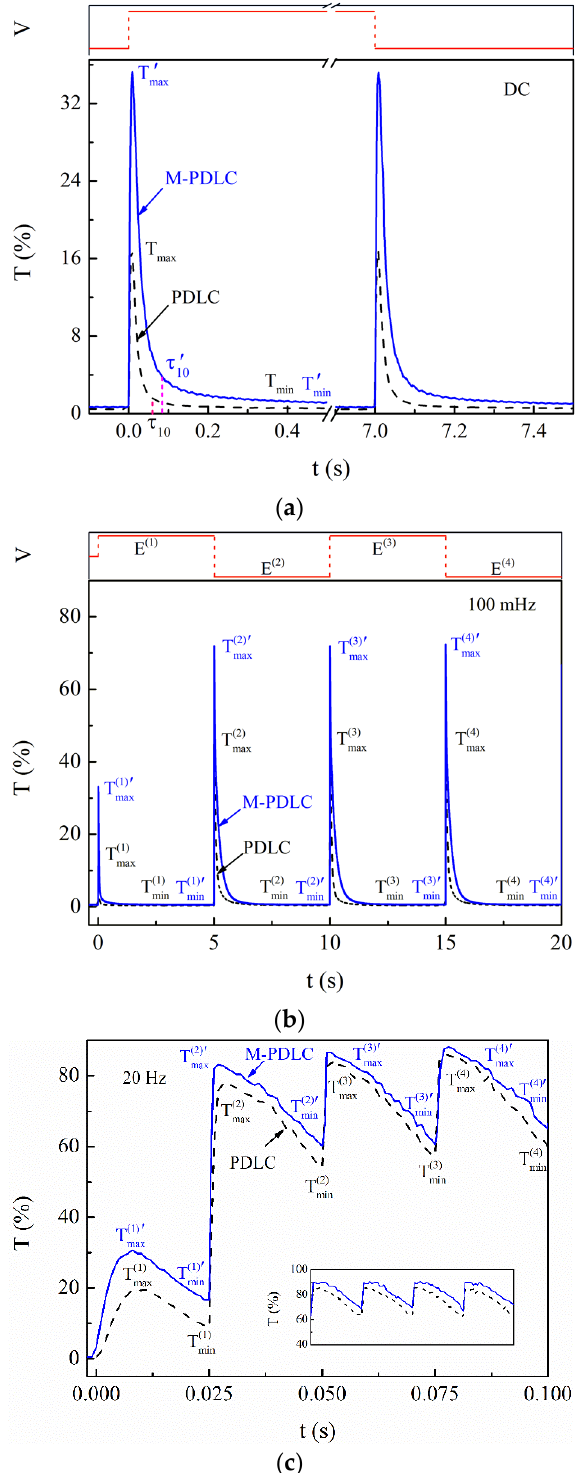
Figure 7. The T-t curves of the PDLC film and M-PDLC film applied with a DC voltage and an AC square wave voltage at 100 mHz and 20 Hz, respectively. T_min^((N)) and T_min^((N)) are the minimum and maximum transmittances in the four T-periods for the PDLC sample, respectively. T_min^((N) ′ ) and T_max^((N) ′ ) correspond to the M-PDLC sample. ( a ) DC voltage, ( b ) 0.1 Hz (AC voltage), and ( c ) 20 Hz (AC voltage).